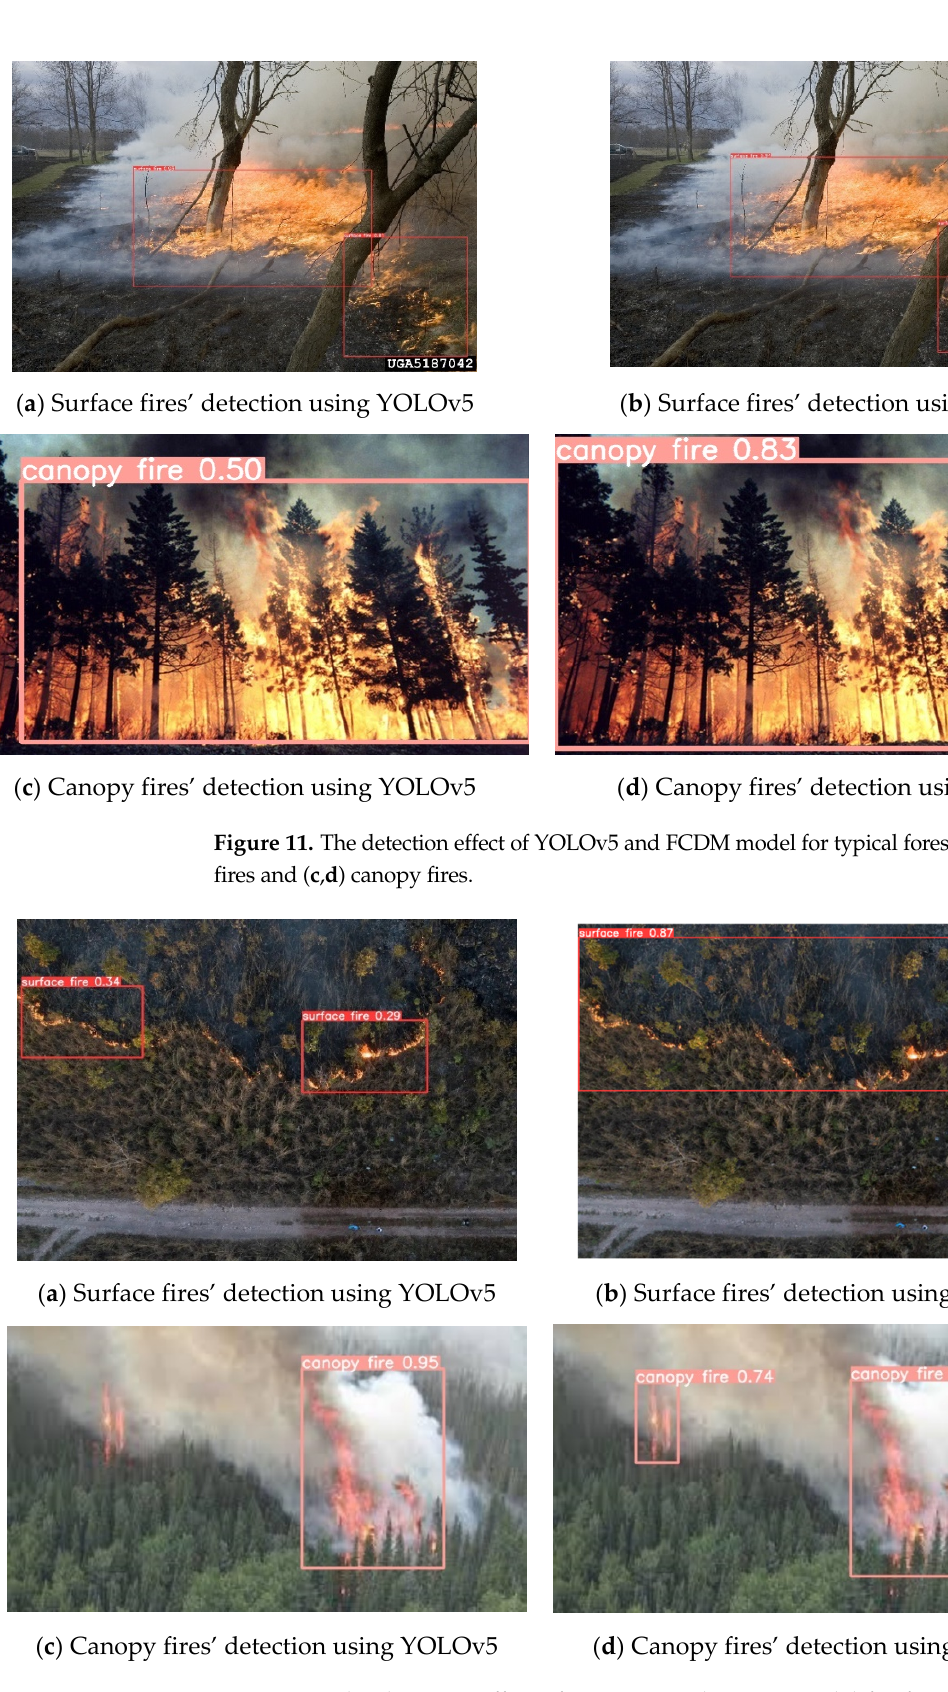
Figure 12. The detection effect of YOLOv5 and FCDM model for forest fire images from UAV viewpoint. ( a , b ) Surface fires and ( c , d ) canopy